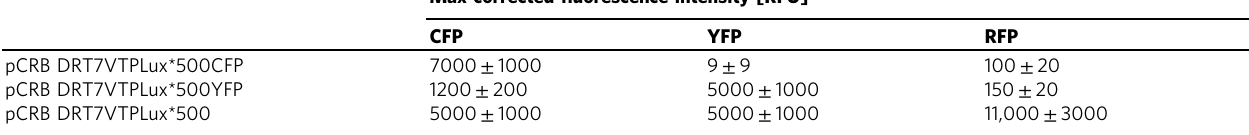
TOP10 E . coli were co-transformed with p4g3R, an mRFP1 -expressing reporter of T7RNAP activity, and the bicistronic controller plasmid pCRB DRT7VTPLux*500 or one of its constitutive half circuits. In contrast to pCRB DRT7VTPLux*500, pCRB DRT7VTPLux*500CFP and pCRB DRT7VTPLux*500YFP lacked either the bicistronic operon P Las81* - T7RNAP [1 – 179]- mVenus or P Lux76* - T7RNAP[180-880] - mTurquoise2 , respectively. The behavior of bicistronic controller plasmid variants was tested alongside the RFP reporter plasmid under a two-dimensional titration of 3OC6HSL and 3OC12HSL using a plate fl uorometer-based assay (see Methods for details). The maximum observed fl uorescence intensity, corrected for background signal present in the absence of externally supplied HSLs, is reported. Values shown are the mean of three biological replicate experiments performed on different days, plus or minus their s.d. Activity plots are shown in Supplementary Figure 4. Individual induction curves are shown in Supplementary Figure